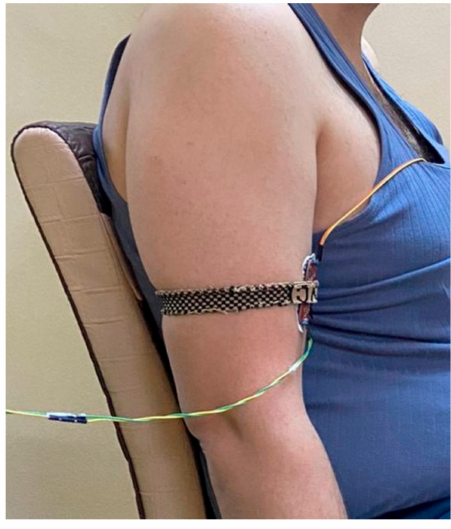
Figure 9. Acquiring the signal from the bicep muscle at relaxed state.